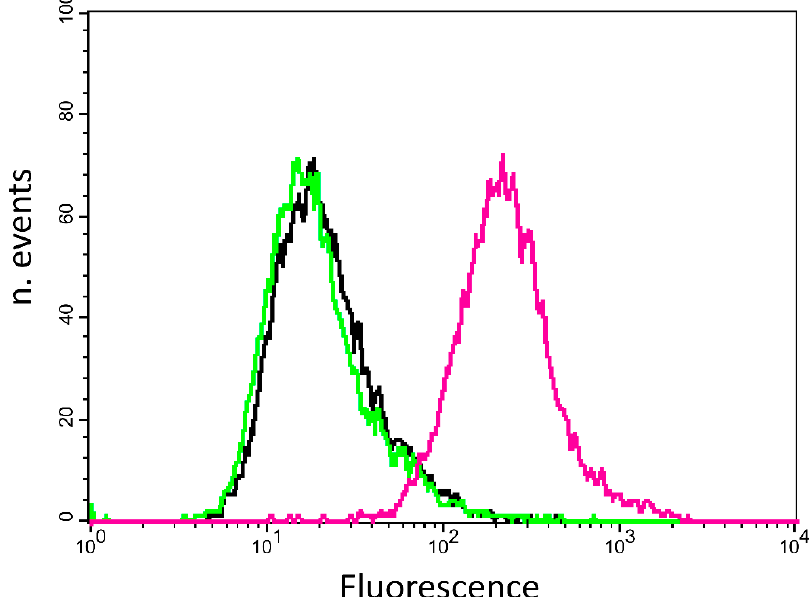
Figure 1. Quantification of α v β 3 and α v β 5 receptors on HepG2 cell surface. Cells were stained with phycoerythrin (PE)-anti- α v β 5 antibody (magenta curve) or PE-conjugated anti- α v β 3 antibody (green curve) or PE-control isotype (black curve). The histogram is representative of three independent experiments.